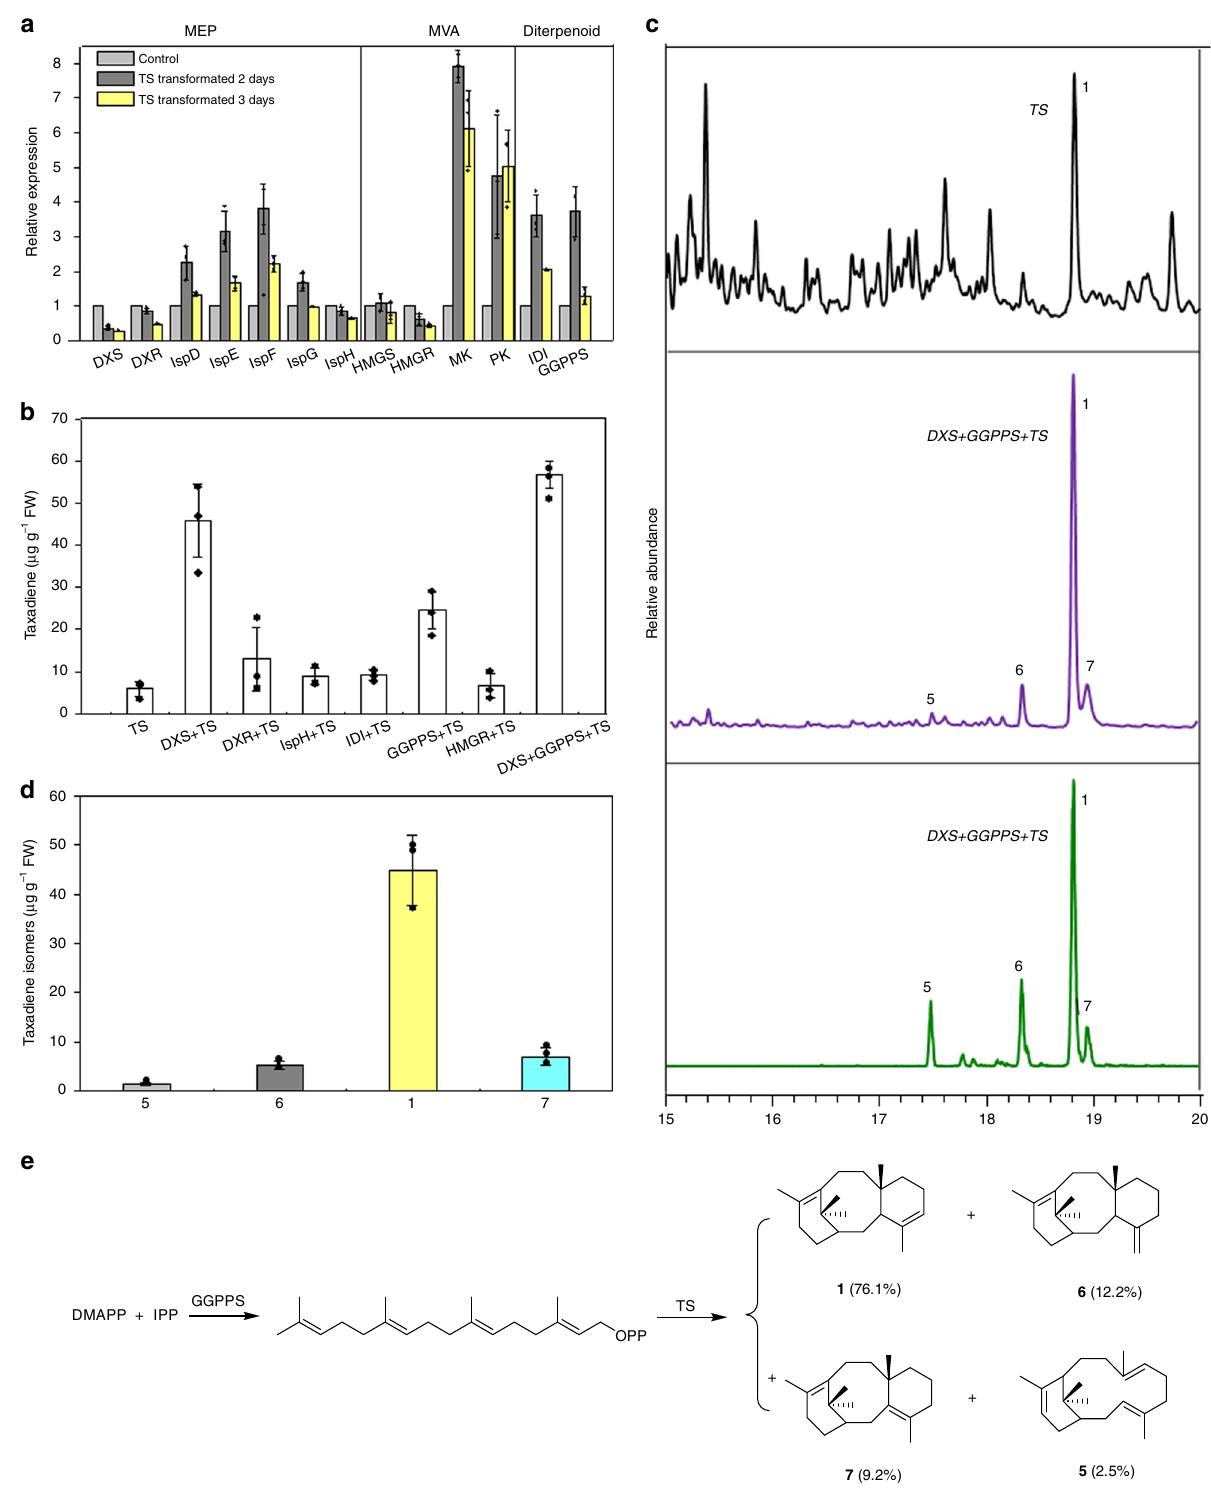
Fig. 5 Identi fi cation of rate-limiting steps in isoprenoid pathway and precursor enhancement for taxadiene biosynthesis. a qRT-PCR analysis of MEP and MVA pathway enzymes in control and 2- or 3- days post in fi ltration transient leaves. b Taxadiene accumulation levels of plants engineered for isoprenoid precursor enhancement. c GC-MS analysis of leaf extracts of selected transient leaves. Upper panel - total ion chromatography (TIC) of TS; middle panel - TIC of DXS-GGPPS-TS; lower panel - selected ion monitoring (SIM) of speci fi c m/z 272 for taxadiene from DXS-GGPPS-TS. The compounds taxa-4(5),11 (12)-diene ( 1 ), verticillene ( 5 ), taxa-4(20),11(12)-diene ( 6 ), and taxa-3(4),11(12)-diene ( 7 ) represent various taxadiene isomers. d Accumulation of 4 taxadiene isomers in DXS-GGPPS-TS co-expression leaves; e The enzymatic catalysis scheme of taxadiene synthase on GGPP for generation of taxadiene isomers. Data in a , b and d represent the mean of n = 3 biologically independent samples (closed circles) and error bars show standard deviation. The source data of Figs. 5a, 5b, and 5d are provided as a Source Data fi le